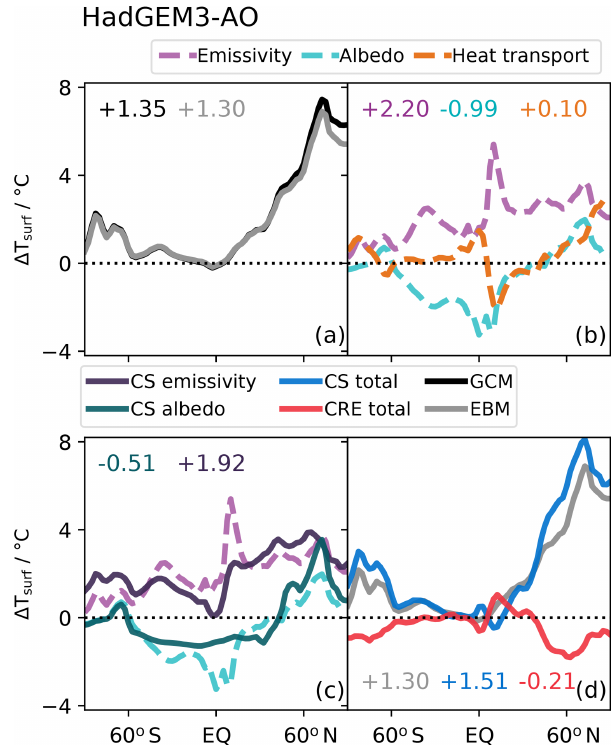
. (a) EBM re- . (a) EBM results Figure 8. 1-D EBM decomposition for PI-GEM 35 10 10 (grey) vs. GCM results (black). (b) Decomposition of EBM into the emissivity (purple), albedo (green) and heat transport (orange) com- ponents of the temperature change. (c) Clear-sky emissivity (dark purple) and clear-sky albedo (dark green) components of the EBM. The all-sky components are included for comparison. (d) Decom- position of EBM into the total clear-sky (blue), cloudy-sky (red) and all-sky (grey)